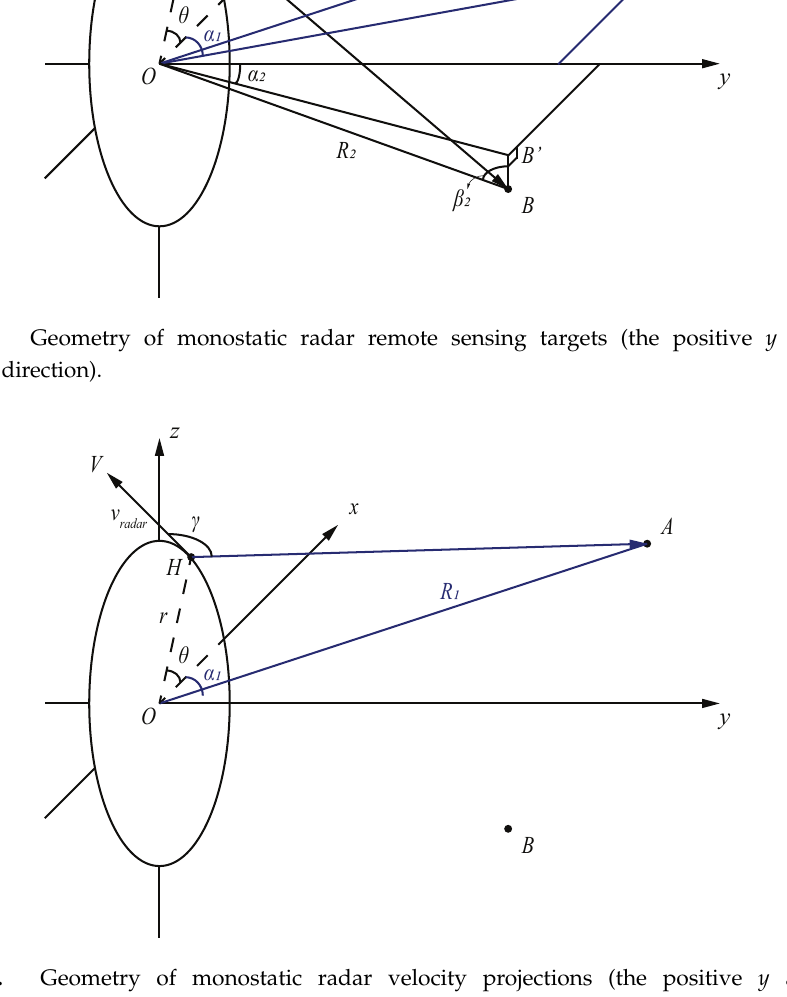
Figure 3. Geometry of monostatic radar velocity projections (the positive y axis is the boresight